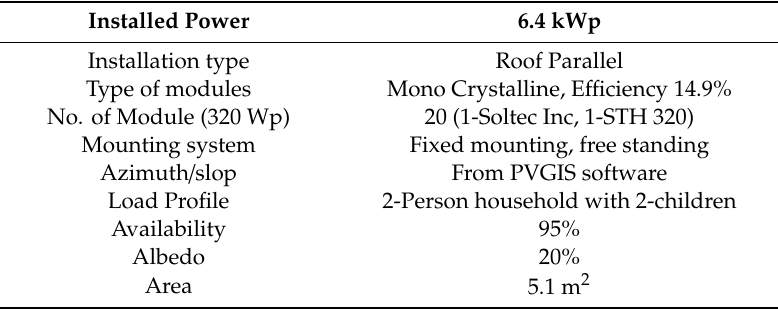
Table 2. Description of a 6.4 kWp rooftop system.